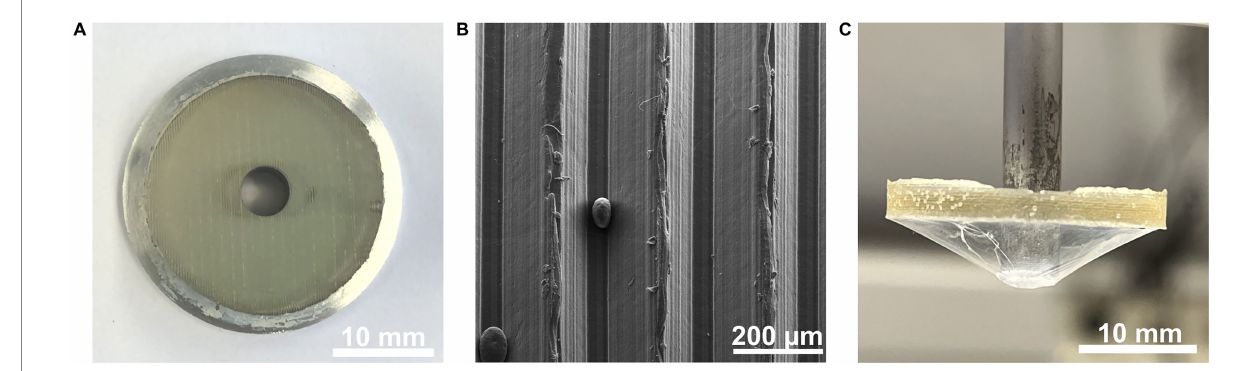
FIGURE 12 (A) Photography of the triangular surface-structured sample made of epoxy resin (B) SEM-image of the triangular surface structure on the epoxy resin specimen. One can see the individual triangles of the surface geometry with a tip spacing of about 250 µm. (C) Photography of the nonwoven layer peeled off from the epoxy resin sample. The weight of the piston used for peel-off force measurement was enough to detach the nonwoven layer from the surface-structured epoxy resin specimen. Note that panel (C) is depicted upside down after peel-off for reasons of better illustration.